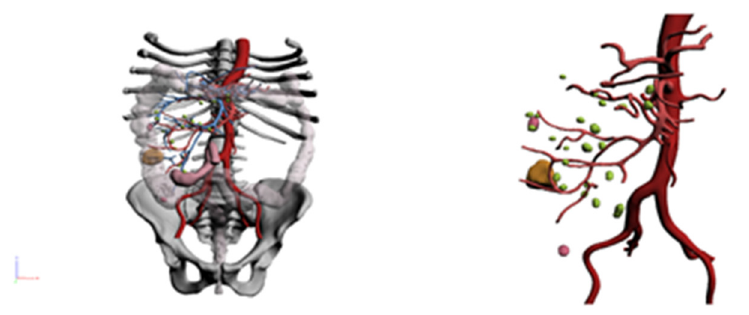
Figure 7. 3D reconstruction (Case